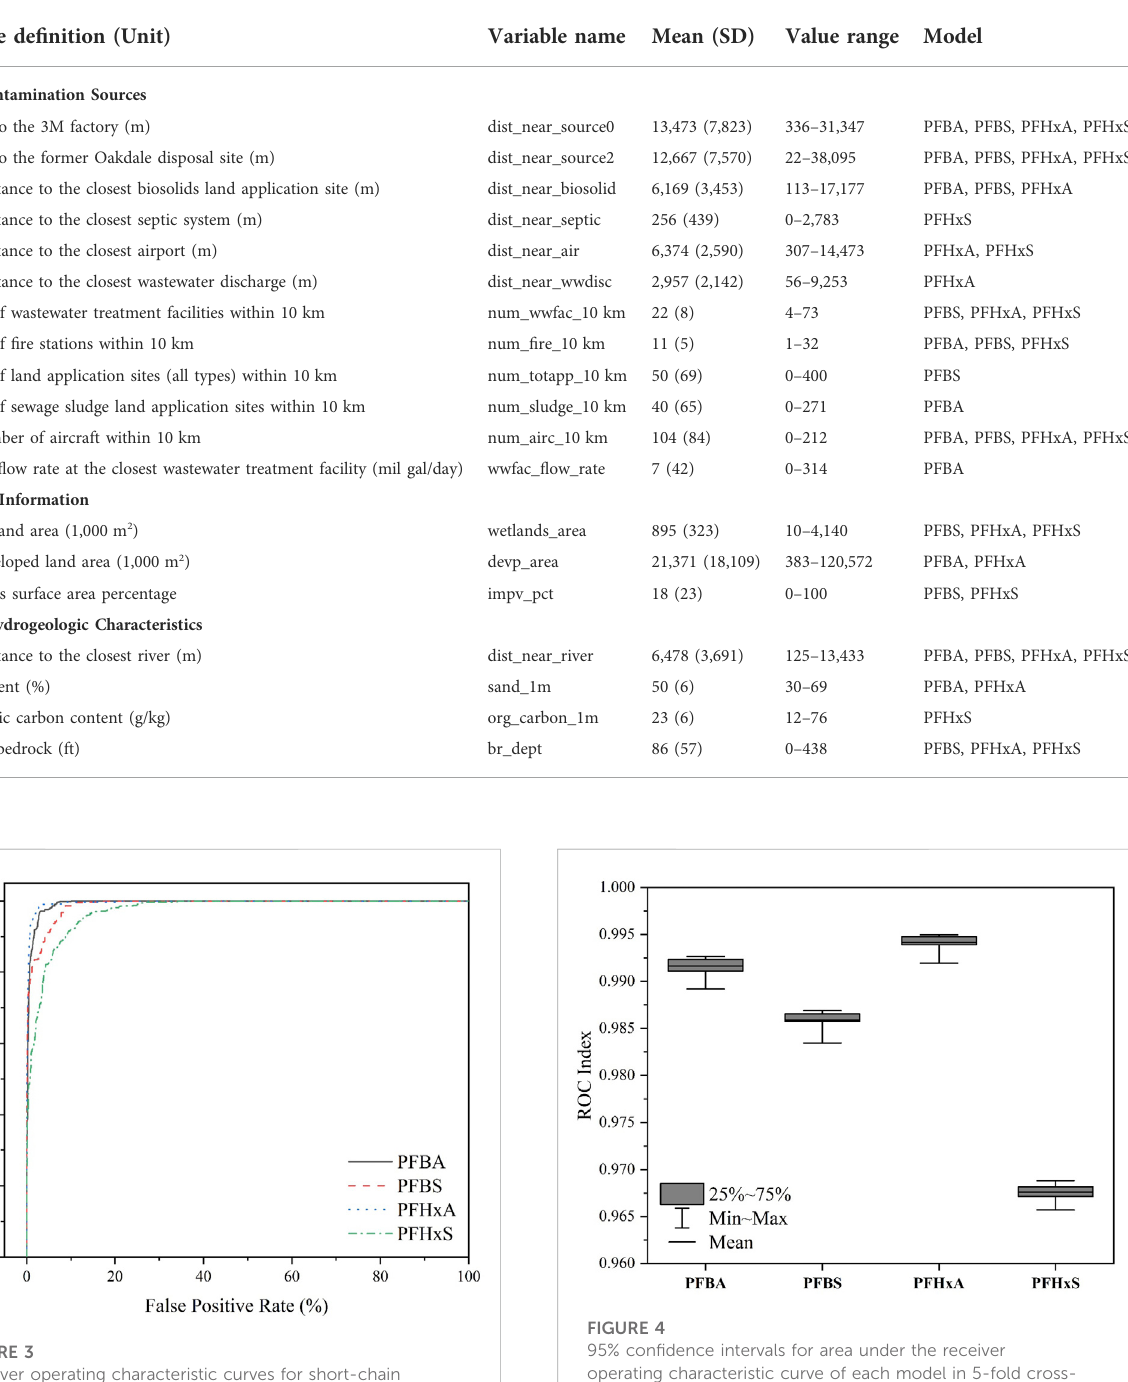
TABLE 2 Variables selected by automated algorithms in at least one of the four Bayesian networks.